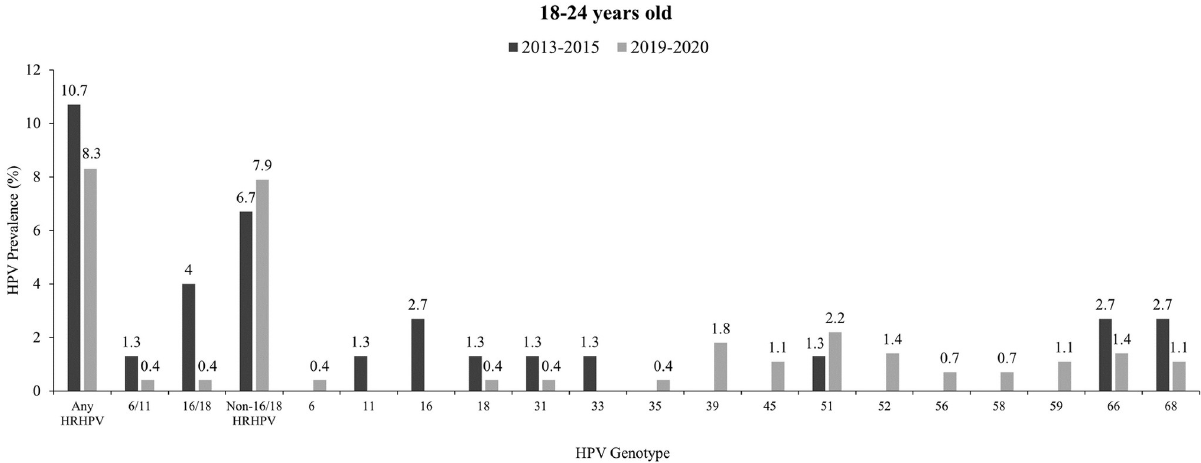
Fig 1. Distribution of HPV genotypes among women aged 18–24 across two study periods. Non-16/18 HRHPV infections contributed to 95% (7.9% of 8.3%) of the overall HRHPV prevalence in 2019–2020 whereas in 2013–2015, 62.6% (6.7% of 10.7%) of HRHPV prevalence was made up of non-16/ 18 HRHPV infections. Abbreviations: CI, confidence interval; HPV, Human